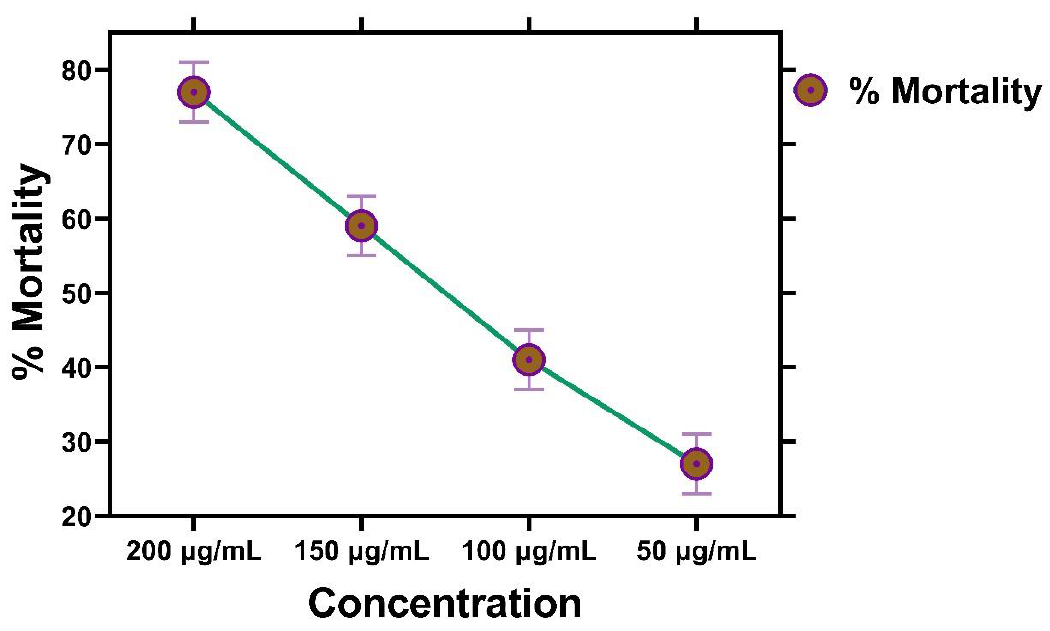
Figure 11. Cytotoxicity potential of IONPs against brine shrimp.